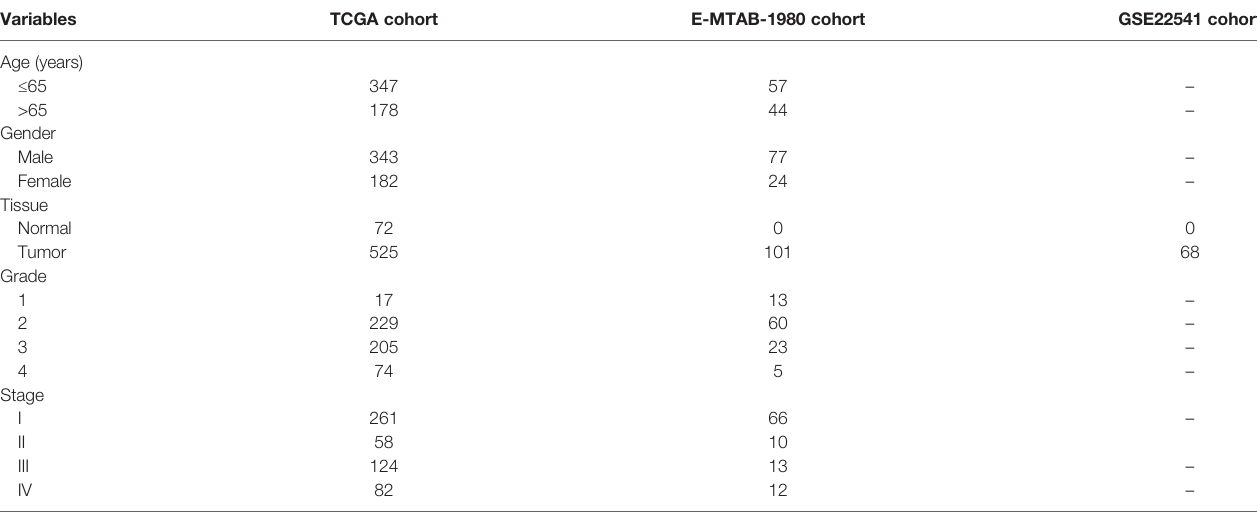
TABLE 1 | Clinicopathological characteristics of the KIRC patients included in this